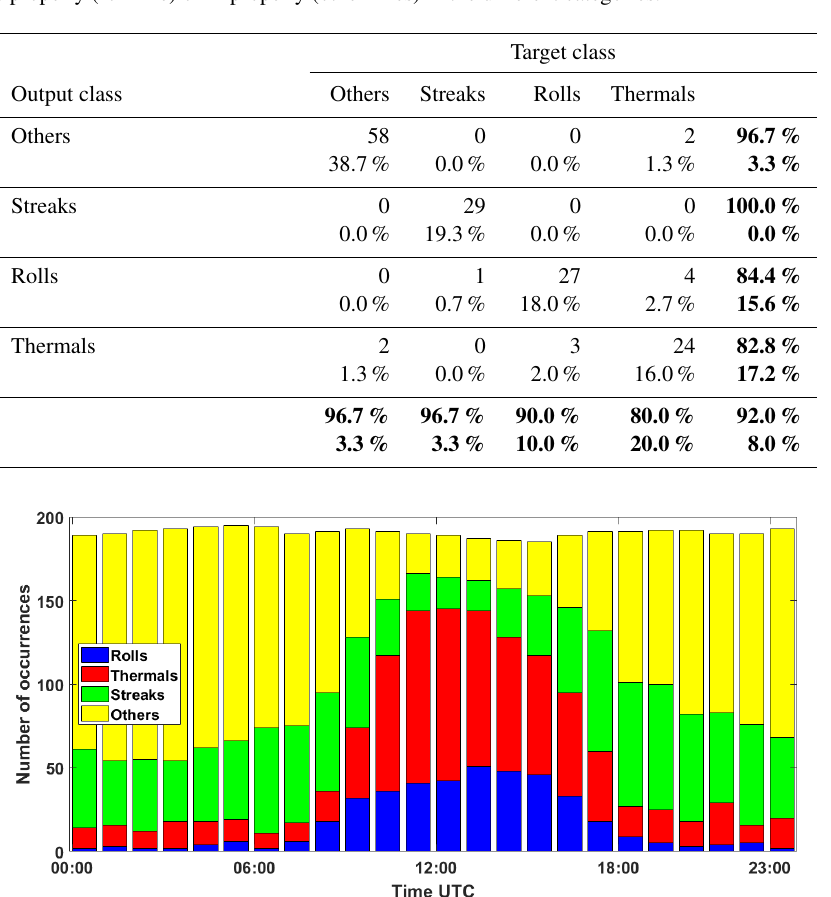
Table 5. Confusion matrix calculated for the training dataset. The “target class” corresponds to the visual classification, while the “output class” corresponds to the class attributed by the algorithm. Therefore, the cells in the “roll” column, for instance, give the number of roll cases that were classified properly (roll line) or improperly (other lines) in the different categories.